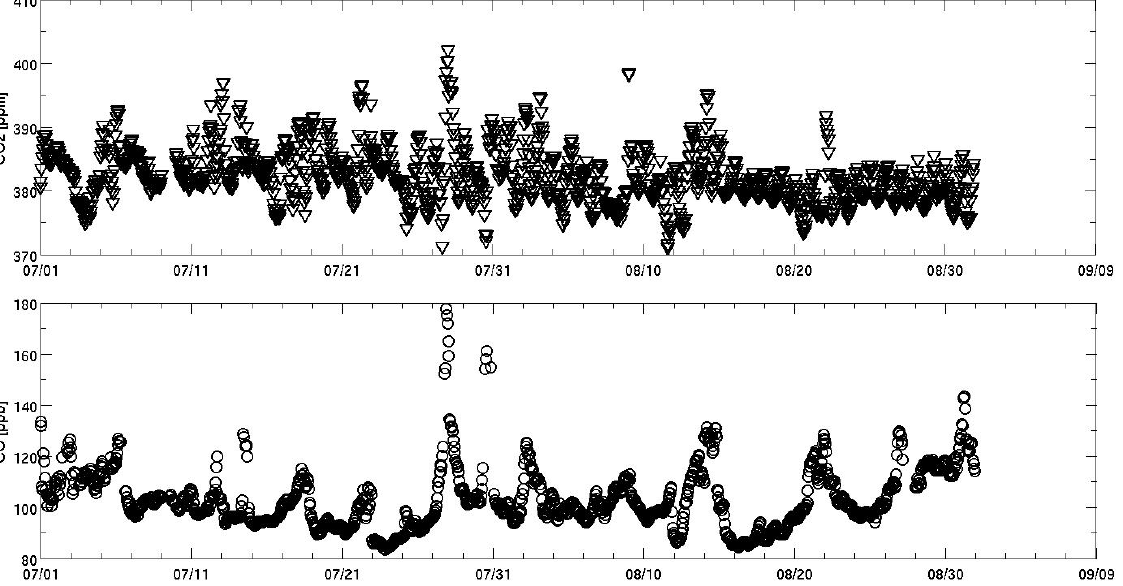
Figure 3. Time series of CO